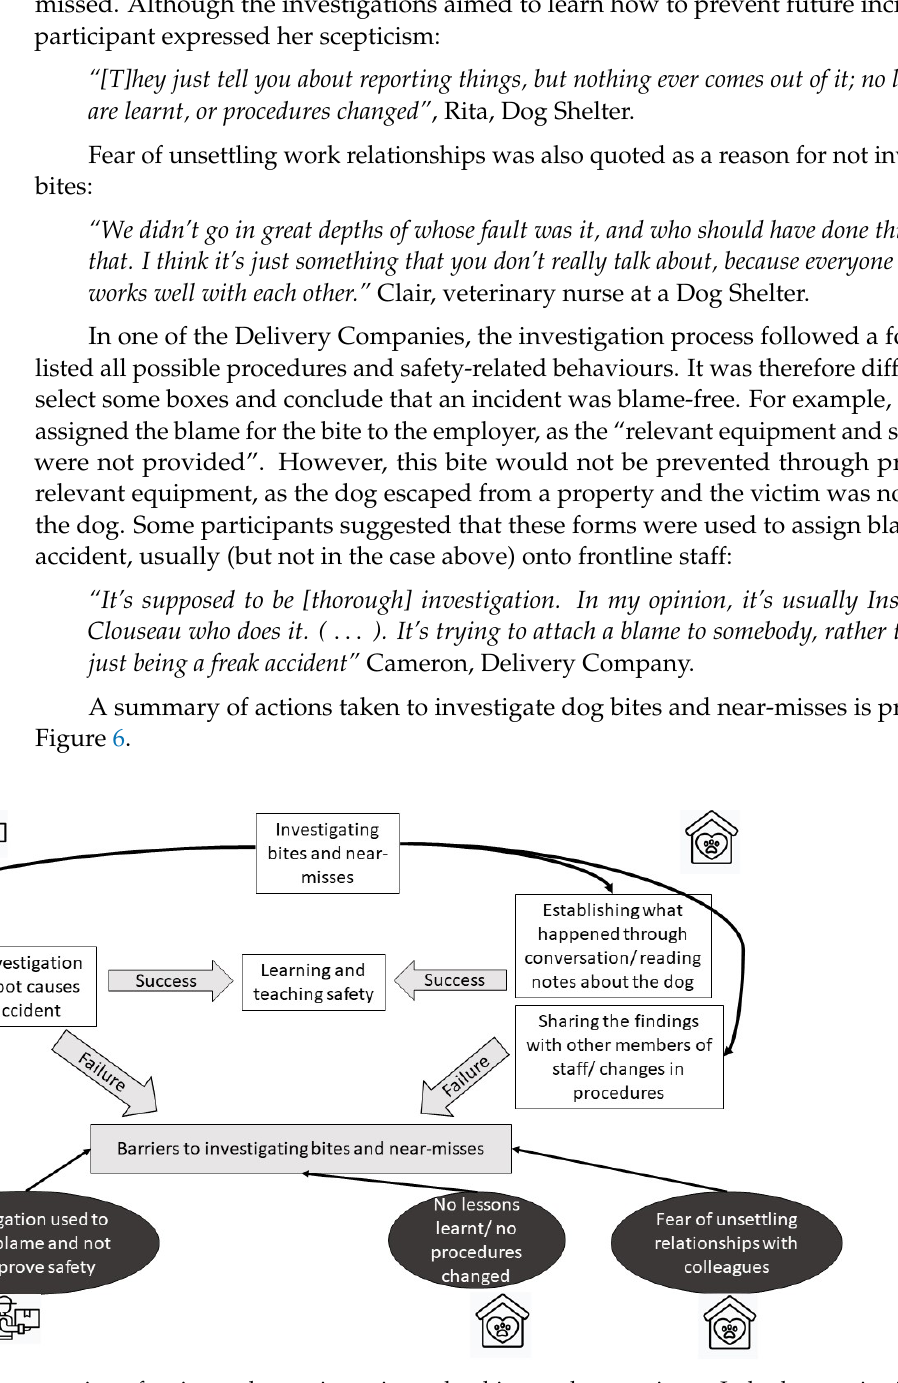
Figure 6. Schematic representation of actions taken to investigate dog bites and near-misses. In both organisations, a successful investigation enables learning from the incident and improvements in safety. A number of barriers to investigating dog bites has been identified in both dog shelters and delivery